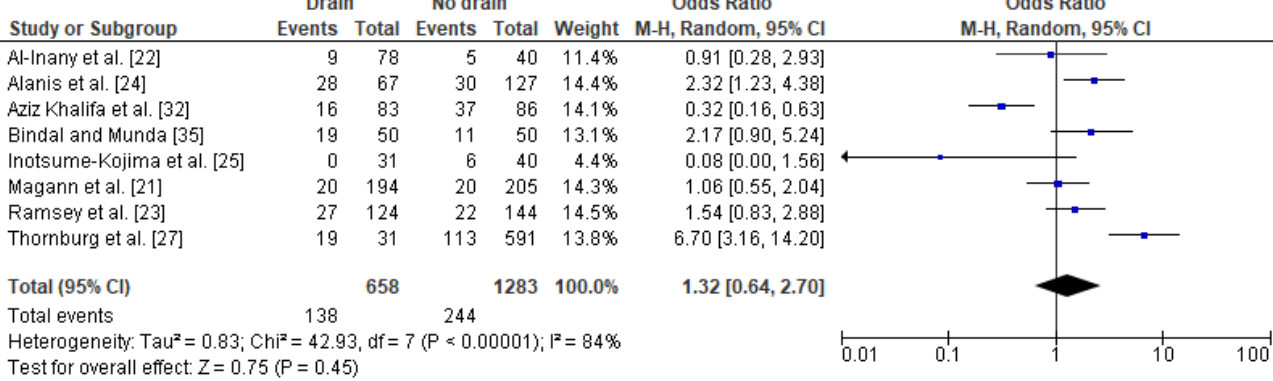
Figure 3. Forest plot for wound complications in the group of post-caesarean obese women with a drain and in the group of obese women without a drain. M.-H.—Mantel-Haenszel; CI—confidence interval; I 2 —heterogeneity; df—degrees of freedom.